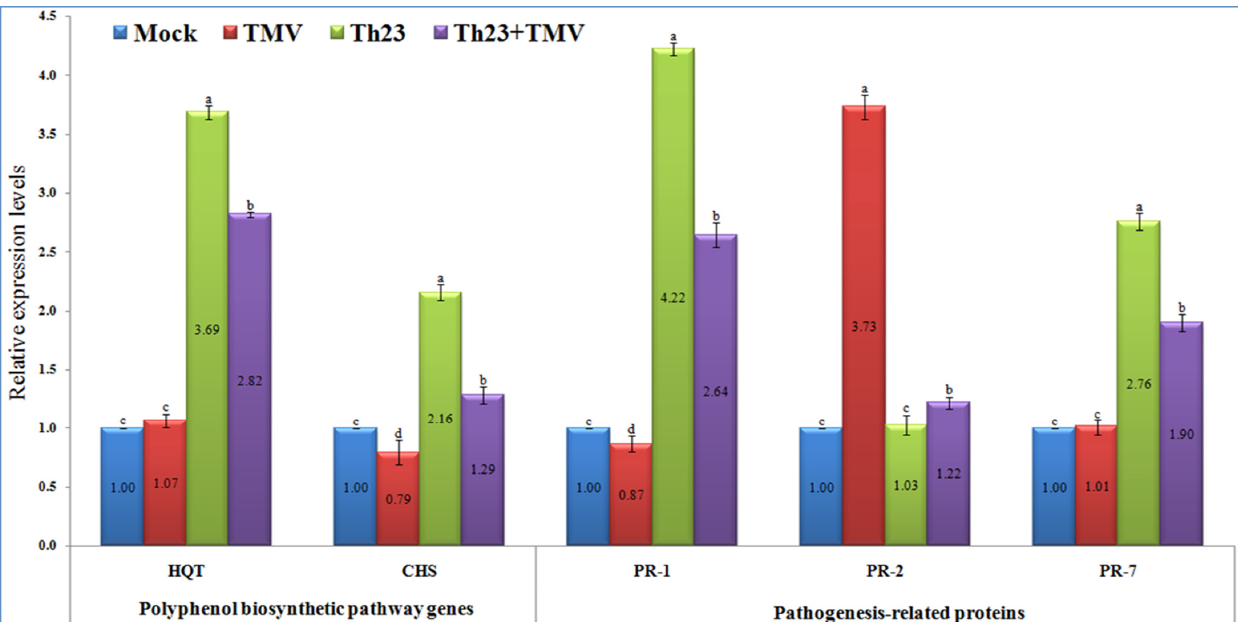
Figure 5. Polyphenol biosynthetic pathway genes ( HQT and CHS ) and pathogenesis-related proteins’ ( PR-1 , PR-2 , and PR-7 ) relative expression levels quantified by qRT-PCR as affected by various treatments including untreated plants (mock), TMV-treated plants (TMV), Trichoderma hamatum strain Th23 application (Th23), and T. hamatum strain Th23 application 48 h before TMV inoculation (Th23 + TMV). The mean values in each of the columns that begin with the same letter are not statistically different ( p ≤ 0.05).